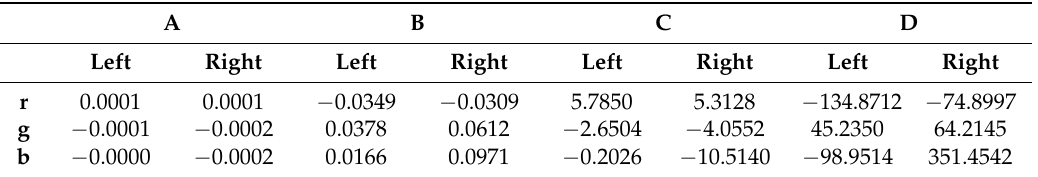
Table 4. Fitting parameters of photoreceptor